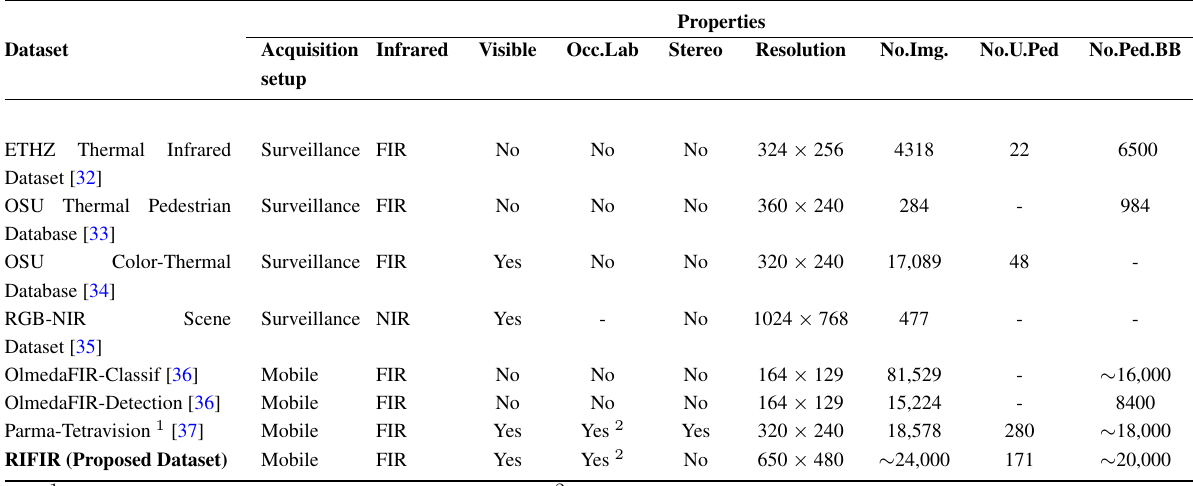
Table 1. Dataset comparison for pedestrian classification and detection in FIR images by acquisition setup (surveillance/mobile), infrared spectrum used (FIR/NIR), if they contain also images taken in the visible spectrum, the availability of occlusion labels (Occ.Lab), stereo information (stereo), image resolution, the number of images in the dataset (No.Img.), the number of unique pedestrians annotated (No.U.Ped) and the number of pedestrian bounding boxes